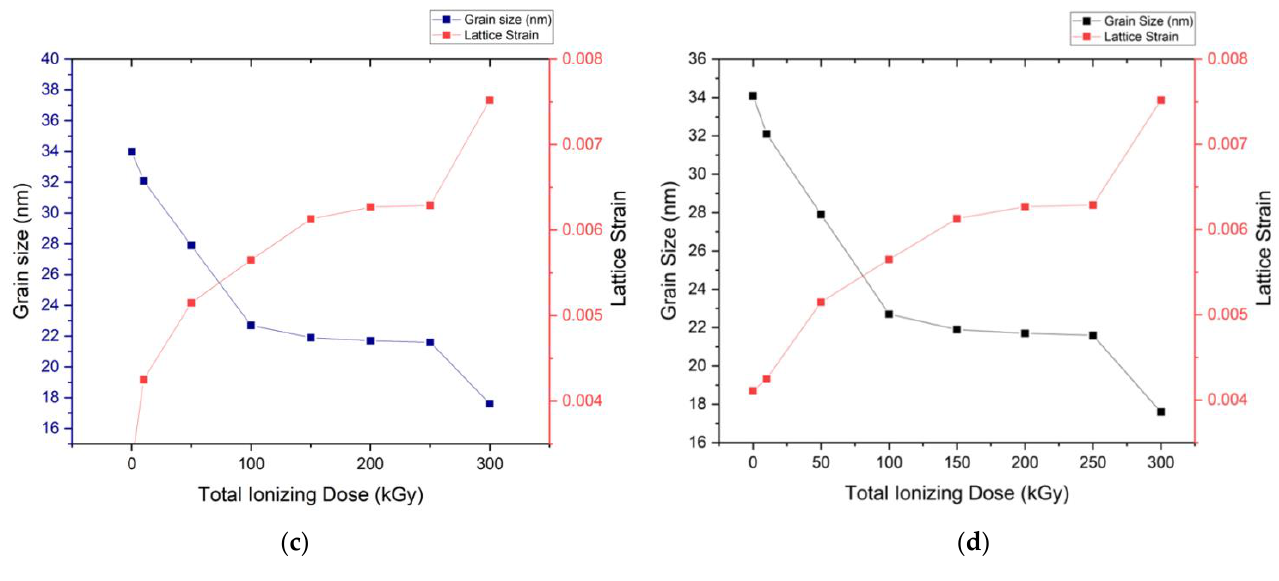
Figure 1. XRD of ( a ) ZnO ( b ) MgZnO pre- and post-irradiation changes. The effects of gamma radiation with TID on the lattice parameters of ZnO and MgZnO. ( c ) Grain Size ( d ) lattice strain, respectively.